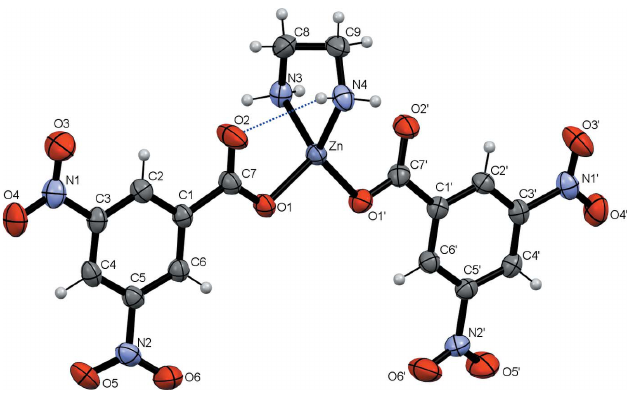
Figure 2 A packing diagram for [Zn(DNBA) 2 (En)] showing the two-dimensional networks parallel to (010). For clarity, H atoms not involved in hydrogen bonding are omitted.